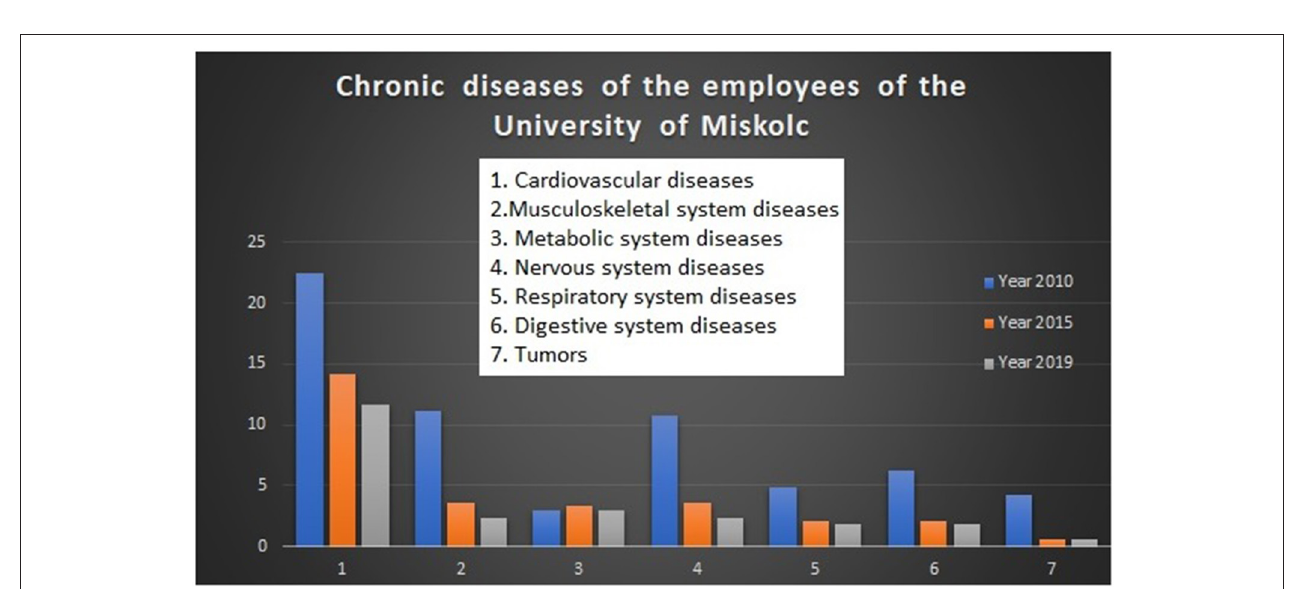
FIGURE 4 | Decrease of the incidence of chronic diseases of employees of the